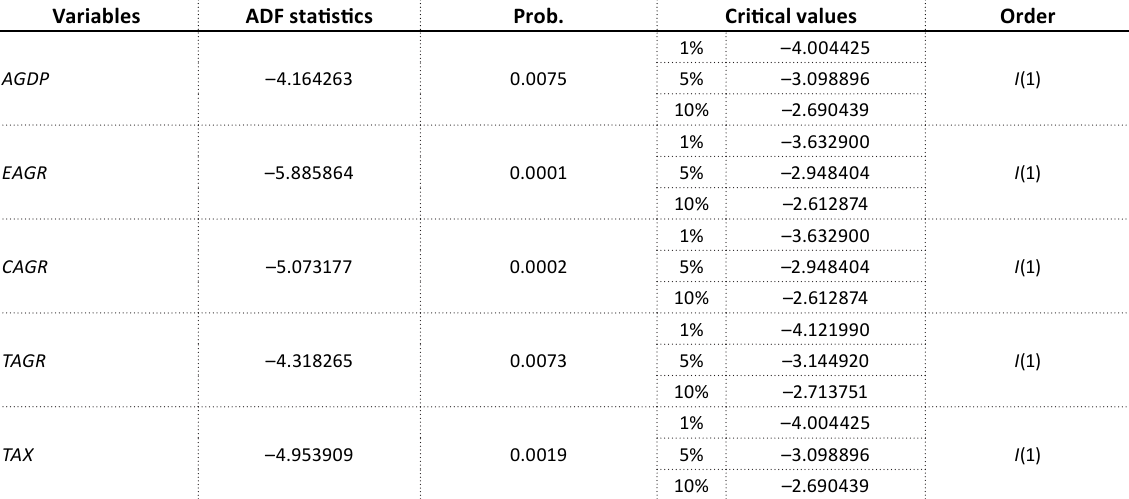
Table 1. Unit root